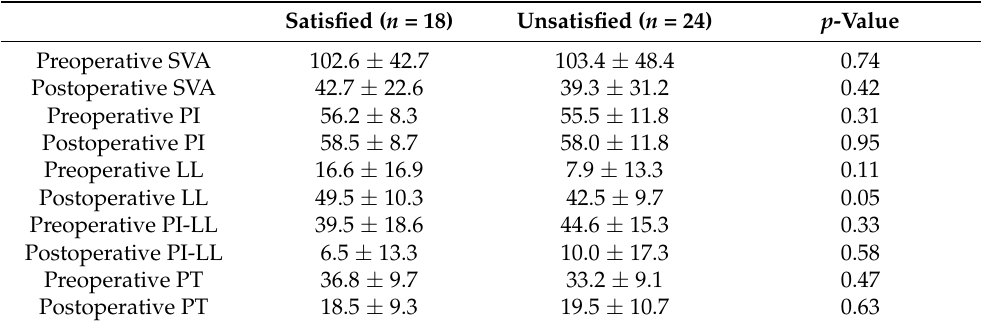
Table 2. Spinopelvic parameters of the two groups. Satisfied ( n = 18) Unsatisfied ( n = 24) p -Value